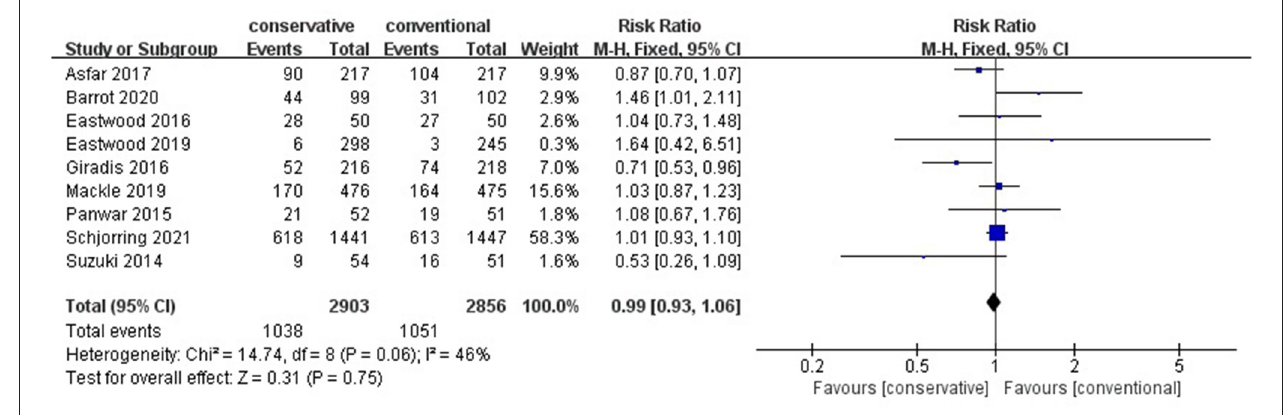
FIGURE 1 | Overall mortality. CI, confidence interval; SD, standard